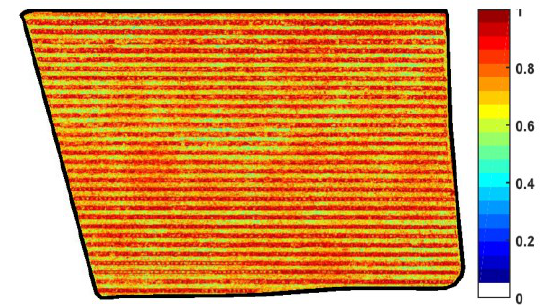
Figure 4. NDVI entropy image for orchard#1.